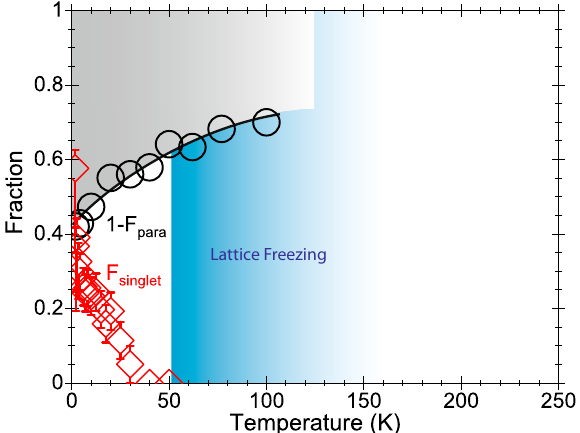
Fig. 10 Volume fraction of paramagnetic and spin-singlet sites. 1 − F para ( ∘ , obtained from the results in Fig. 1d) represents the shrinking volume fraction of Zn 0.95 , which is not within the spin- polarized domain and hence could exhibit intrinsic kagome spin liquid behavior without the perturbation caused by interlayer Cu 2 + defects occupying the Zn 2 + sites. Notice that only ~40% of such a volume remains at 2 K in Zn 0.95 . Also shown ( ♢ ) is the upper bound of the spin- singlet fraction F singlet of Cu sites, estimated from the observable 63 Cu NQR signals at the fi xed pulse separation time τ = 6 μ s 21 (The lower error bars below 6 K represent the lower bound of F singlet , estimated based on the assumption that the 63 Cu signal loss affects only the paramagnetic component. All other error bars correspond to the absolute maxima or minima of F singlet21 .) Blue shading schematically shows the temperature range where the freezing of the structural distortion sets in (~160K) and completes